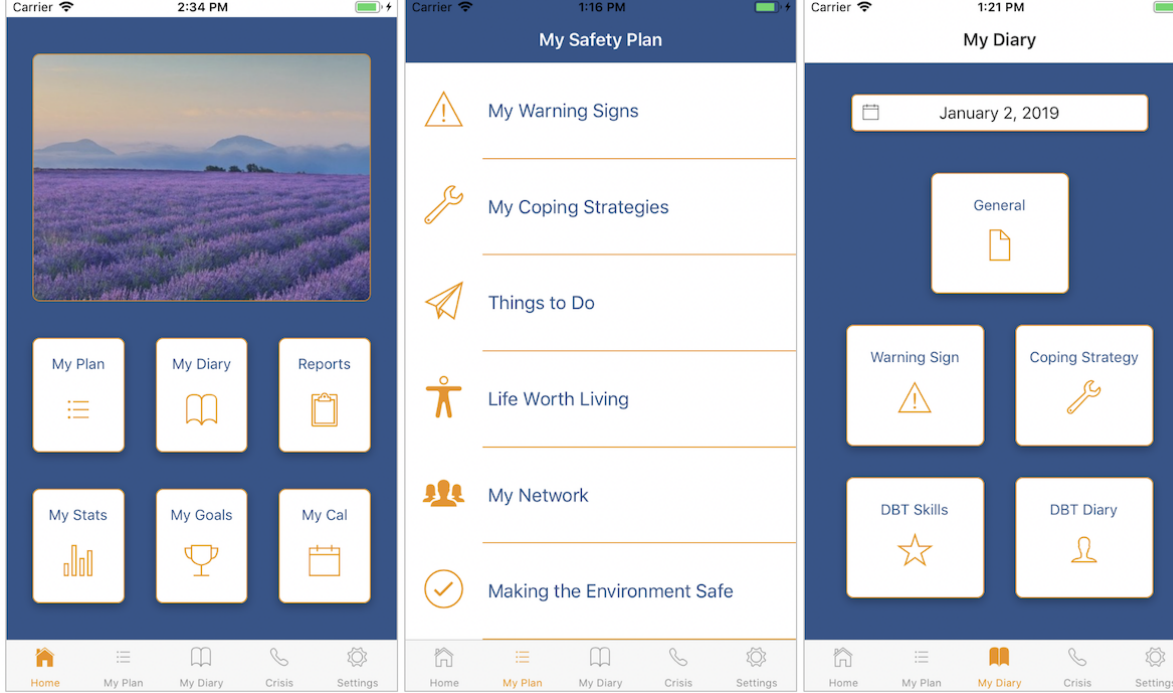
The final step in completing SafePlan’s visual design was devising a color scheme for the app’s UI. Following a presentation of alternate themes, the design team decided on a complementary color scheme for SafePlan. A complementary color scheme uses one base color and its complement, the color on the exact opposite side of the color wheel [28] as an accent color to draw attention to important elements on the screen. A base color of deep blue was chosen by the design team, as blue is a calming color, with the associated accent color being